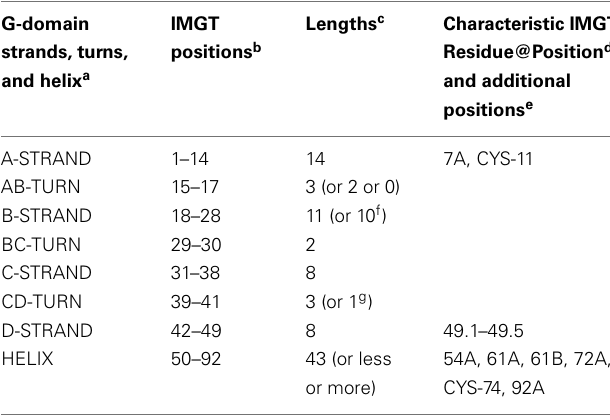
Table 7 | G-domain strands, turns, and helix, IMGT positions, and lengths, based on the IMGT unique numbering for G-domain (G-DOMAIN and G-LIKE-DOMAIN)